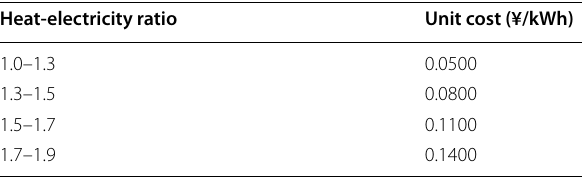
Table 6 Step price of heat-electricity ratio